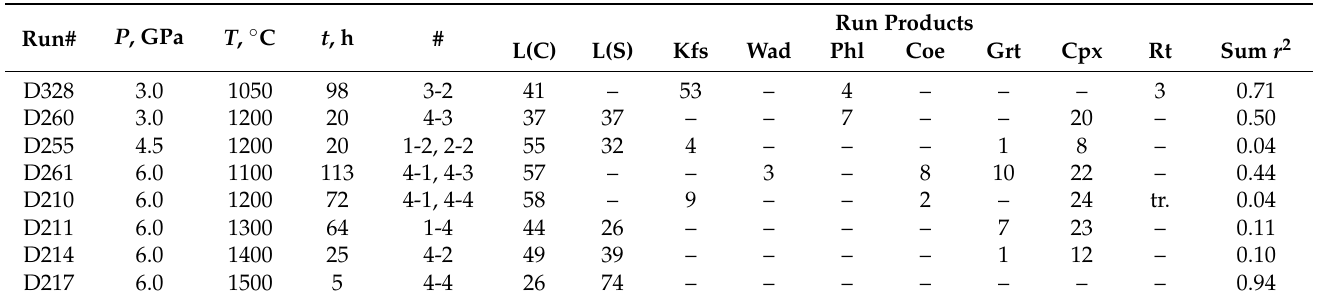
Table 2. Summary of run conditions and calculated phase proportions (mol%) in the system L(S) +